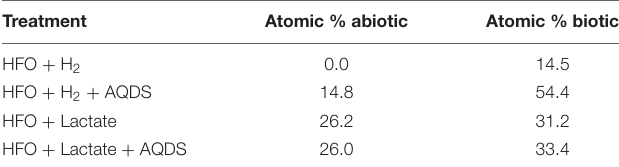
TABLE 2 | Results of fitting multiplet splitting peak models to X-ray photoelectron spectroscopy–derived Fe 2p 3 / 2 photopeaks collected from 2-line ferrihydrite recovered from cultures of UFO1 in the presence and absence of AQDS with H 2 and lactate compared to abiotic controls. Treatment